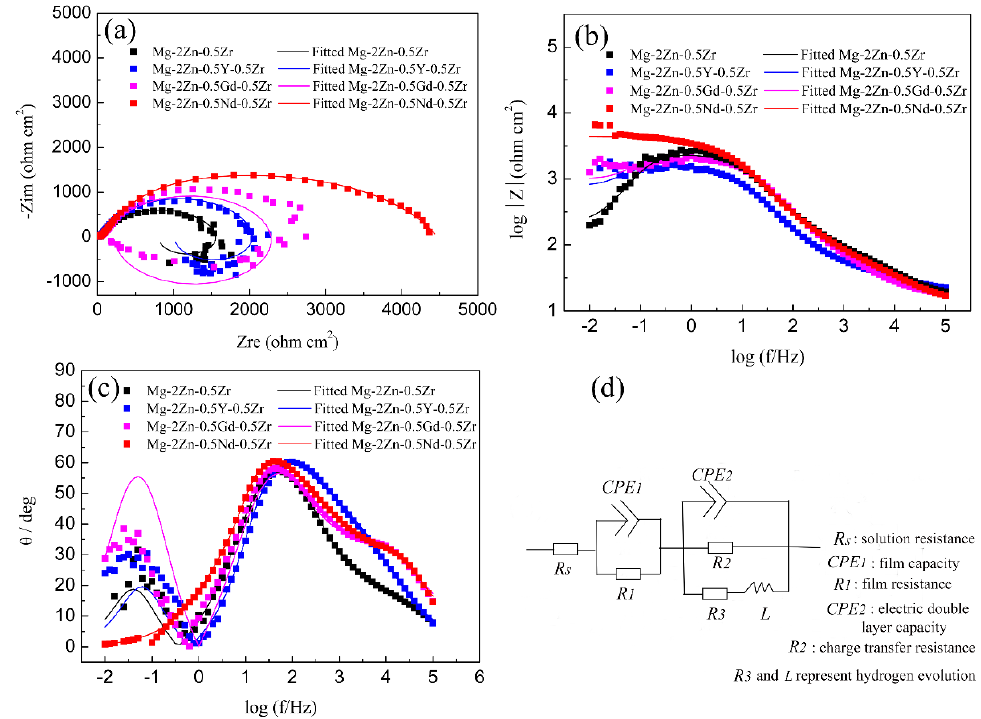
Figure 10. EIS curves of the alloys in Hank’s solution : ( a ) Nyquist curves; ( b ) Bode curves; ( c ) phase angle curves; and ( d ) equivalent circuit. Table 7. Fitting results of the EIS curves based on the equivalent circuit.